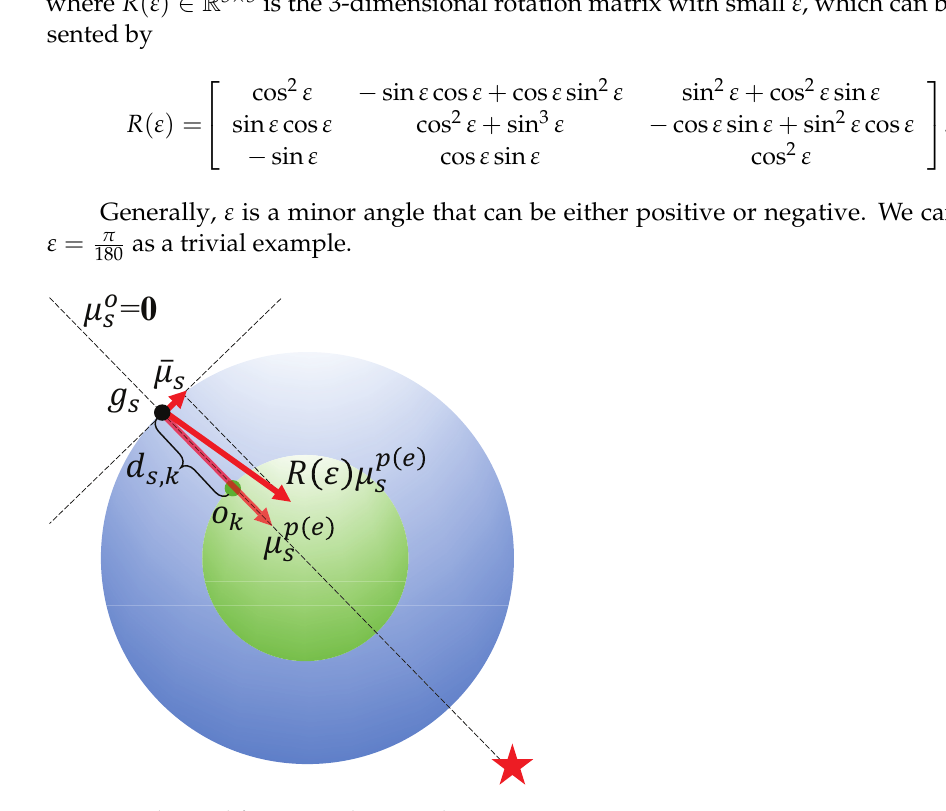
Figure 1. The modification to the special